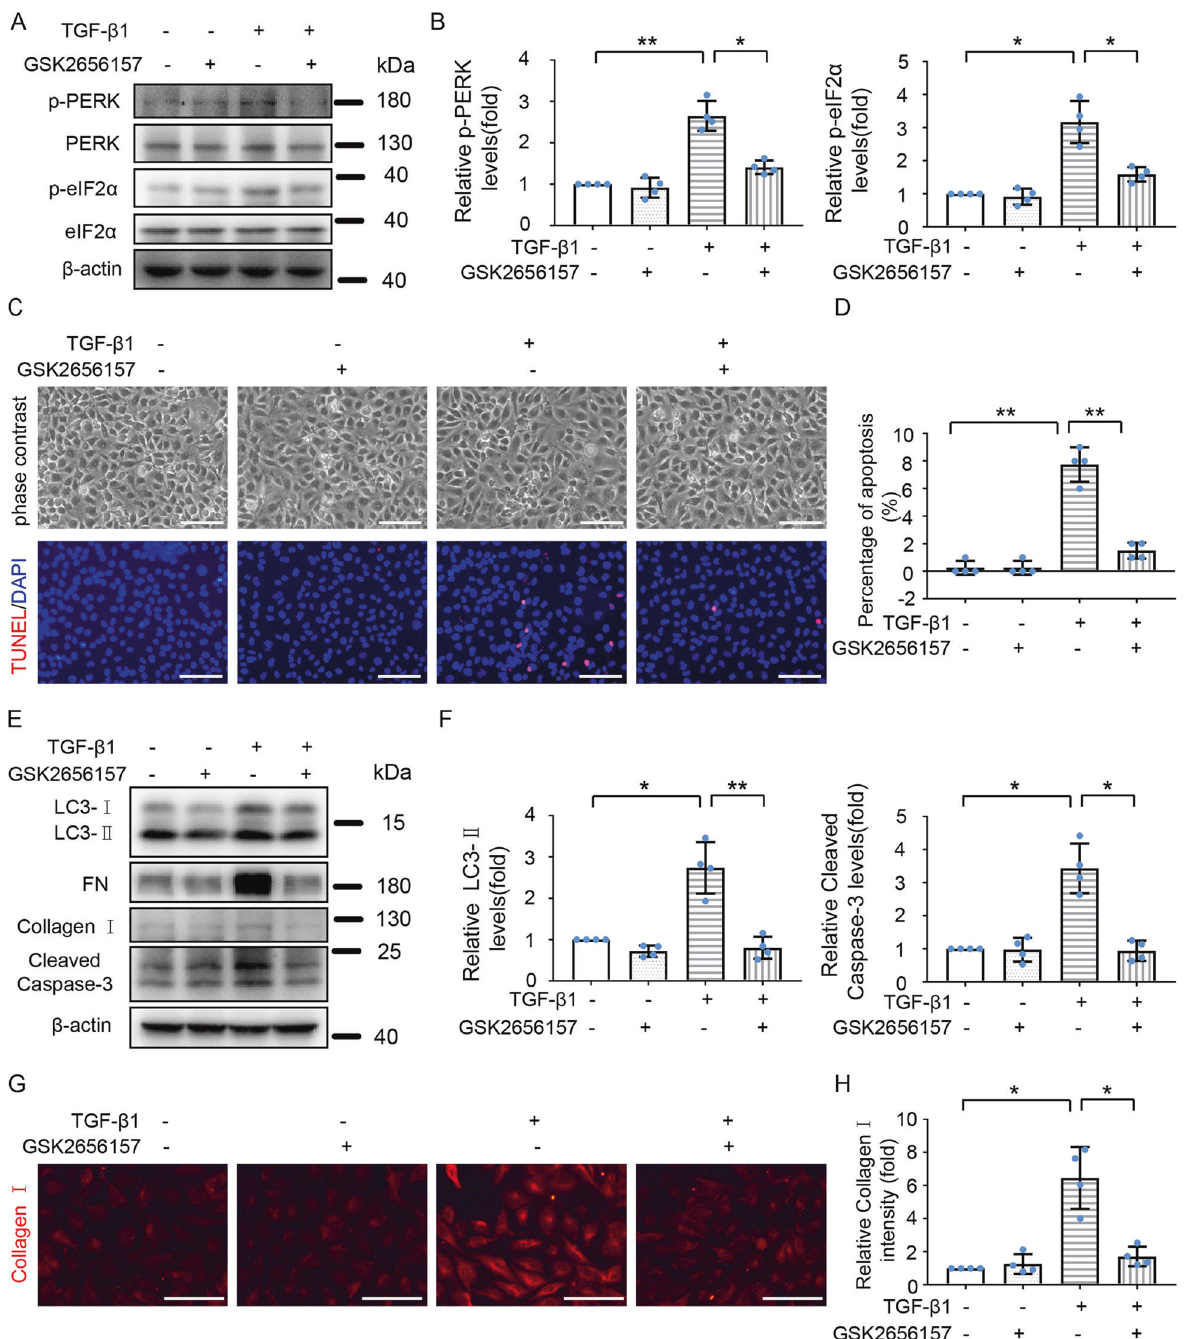
eIF2 α , and β -actin by immunoblot analysis. B Densitometric analysis of p-PERK and p-eIF2 α immunoblots relative to β -actin. C Representative phase-contrast and TUNEL staining images. Scale bar = 100 μ m. D Counting of TUNEL-staining positive cells. E Cell lysates were analyzed for LC3, FN, Collagen I, cleaved Caspase-3, and β -actin by Immunoblot analysis. F Densitometric analysis of LC3-II and cleaved Caspase-3 blots relative to β -actin. G Representative images of Collagen I immuno fl uorescence staining. Scale bar = 100 μ m. H Quantitative analysis of Collagen I immuno fl uorescence intensity. Data are expressed as mean ± SD. n = 4. * p < 0.05; ** p <